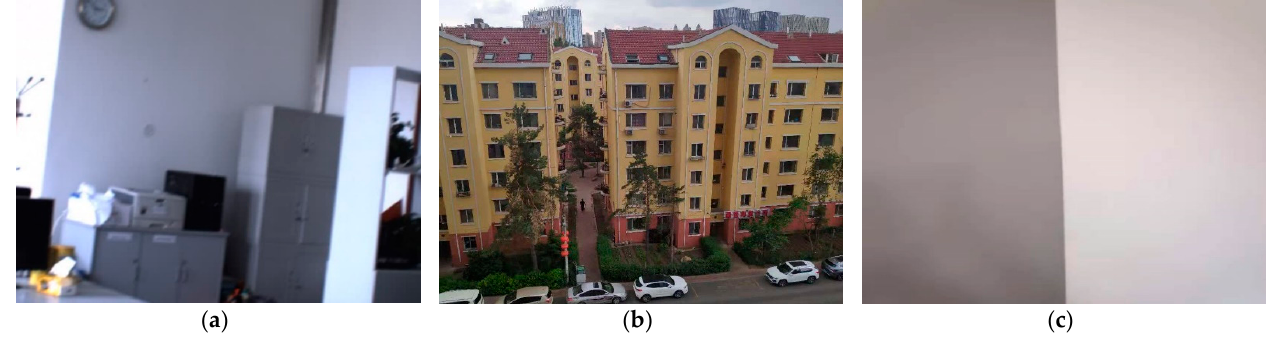
( b ) Figure 9. Assessment of video stabilization results with different spherical radii: ( a ) comparison of PSNRs; ( b ) compari- son of SSIMs. 4.3. Comparison with the Intrinsic Parameter Matrix Method In this paper, three different camera data were used to compare the image stabiliza- tion effect of spherical motion compensation and intrinsic parameter matrix compensa- tion method s [12,13,15]. Figure 10 is a thumbnail of three videos, where video 1 is an in- door scene, video 2 is an outdoor scene, and video 3 is a feature-deficient scene. All the resolutions of the three videos were